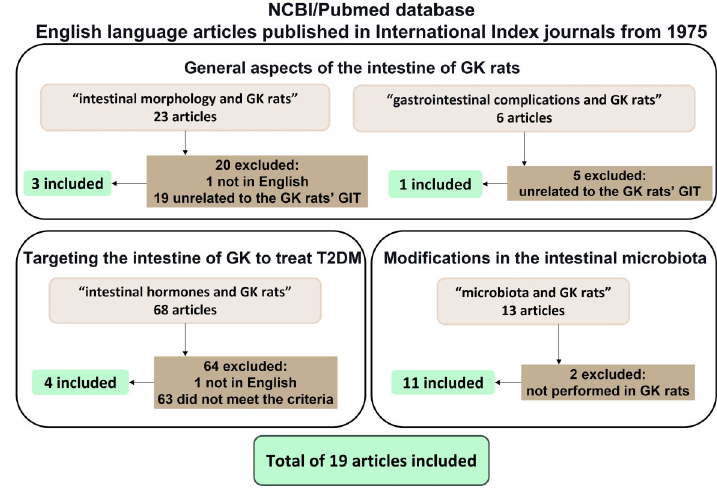
Figure 2. Flow diagrams for selecting articles for each topic. GK: Goto-Kakizaki; T2DM: type 2 diabetes mellitus; GIT: gastrointestinal